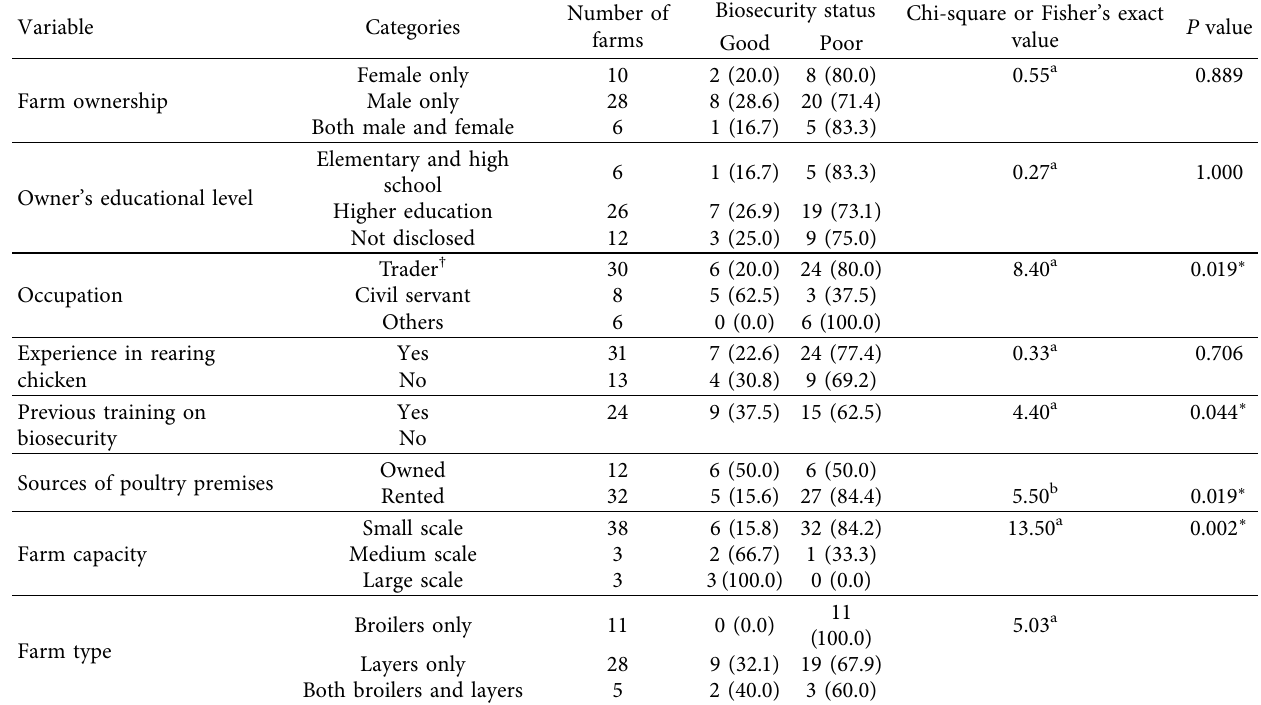
Table 6: Association between biosecurity level and owner’s demography and farm characteristics.